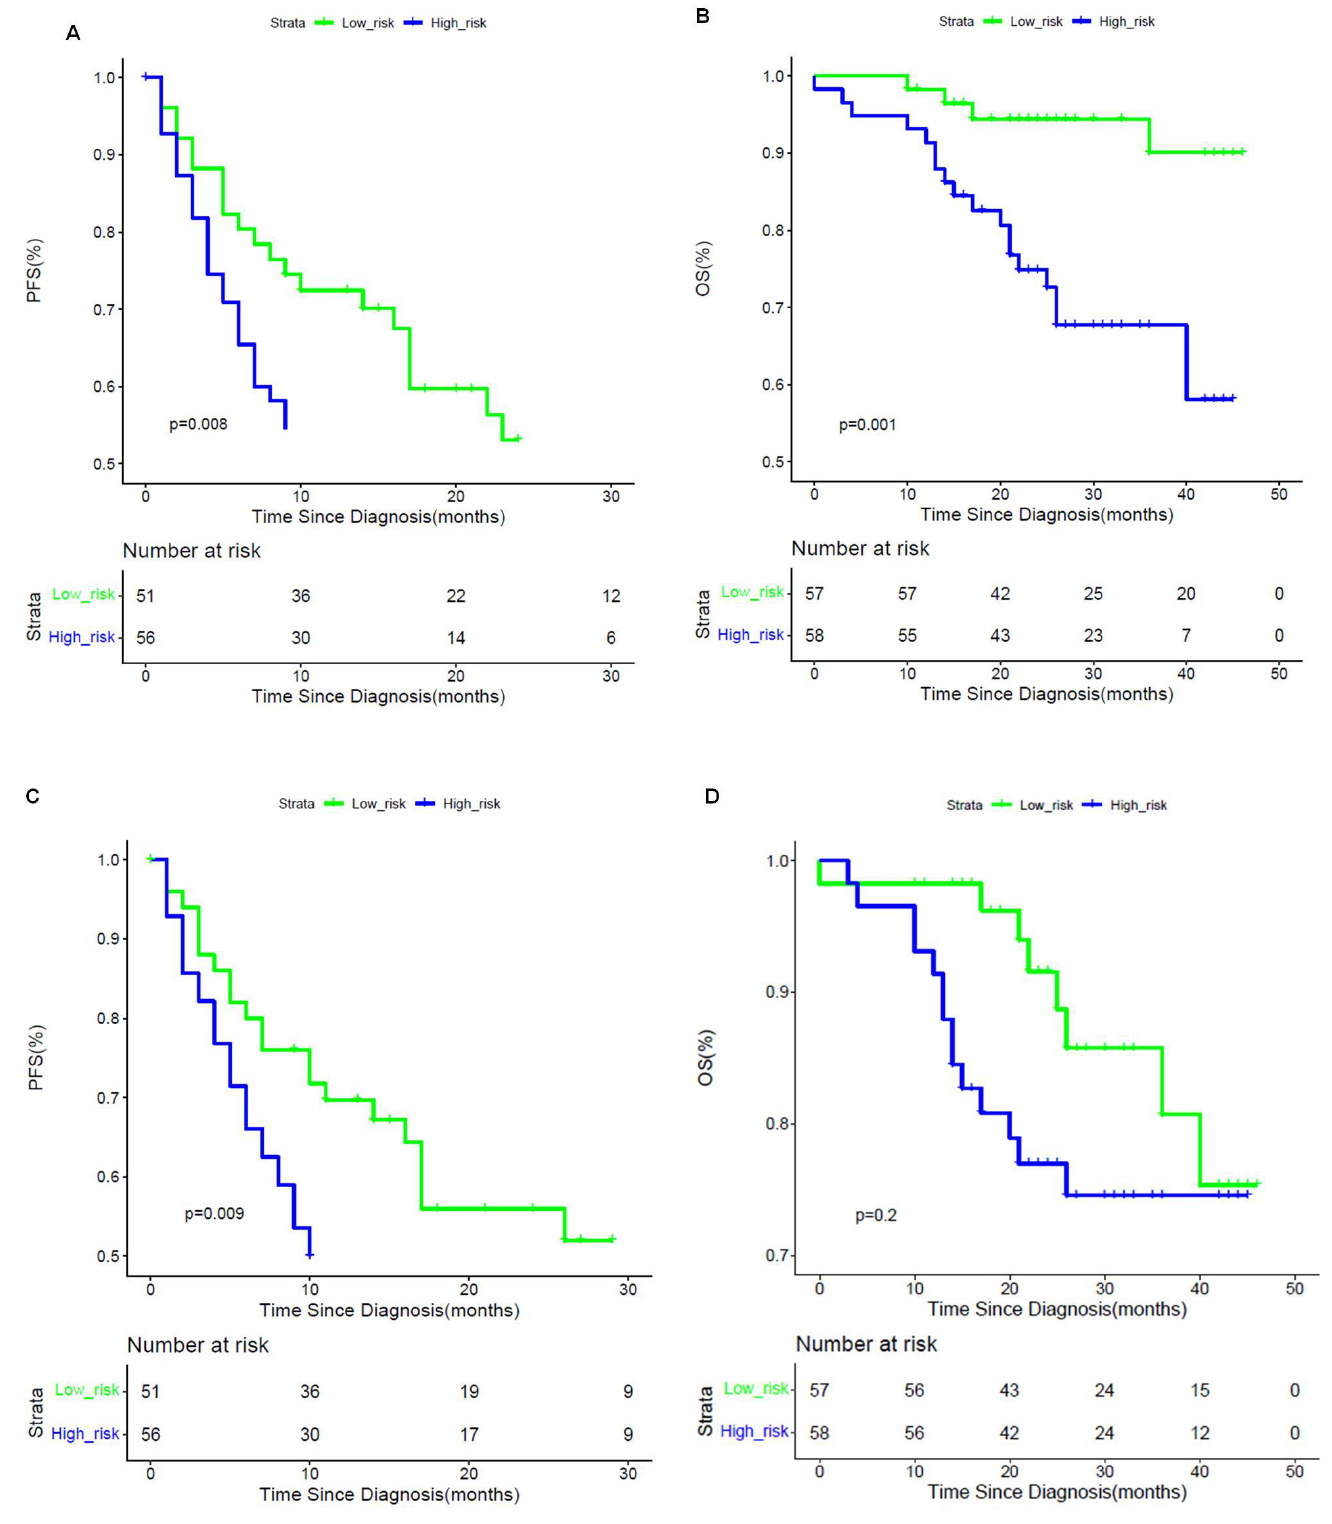
Figure 5. Prognostic analysis using Kaplan–Meier curves on PFS and OS via CDLM EOB-MRI and CDLM CE-CT . PFS ( A , C ) and OS ( B , D ) Kaplan–Meier curves scaled by CDLM EOB-MRI and CDLM CE-CT , respectively. The optimal threshold of CDLM models was determined by the maximum Youden index of ROC curve.